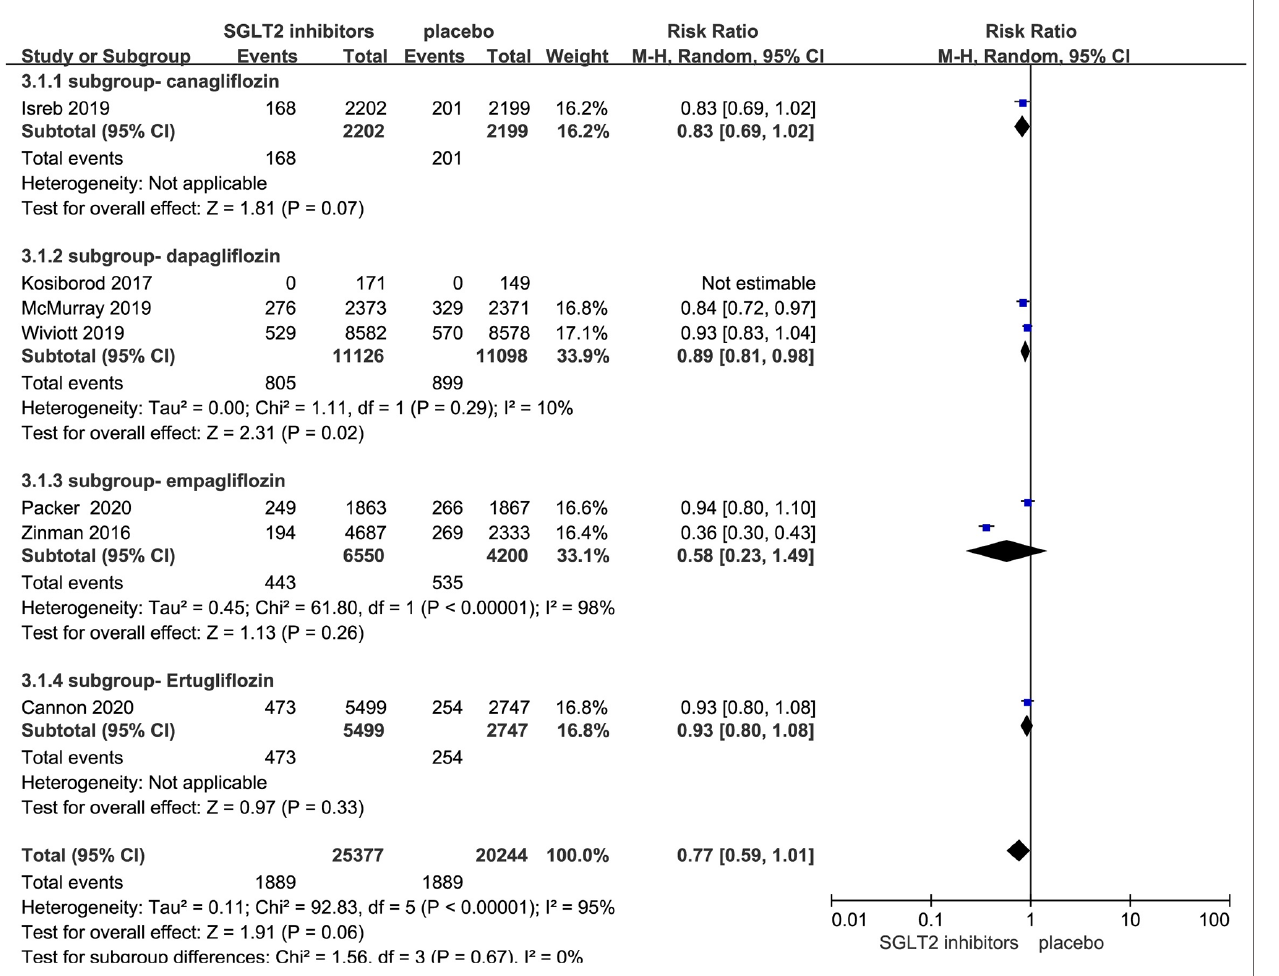
FIGURE 5 | Death from any cause in type 2 diabetes patients receiving SGLT2 inhibitors versus